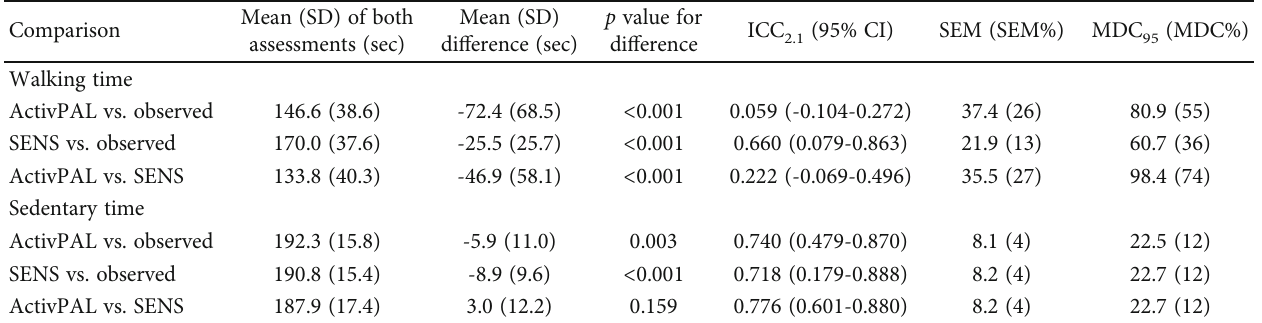
Figure 3: (a – c) Recording of steps: comparison between ActivPAL3 ™ and SENS Table 6: Relative and absolute reliability of walking and sedentary time in seconds, assessed with ActivPAL3 ™ , SENS motion®, and direct observations.